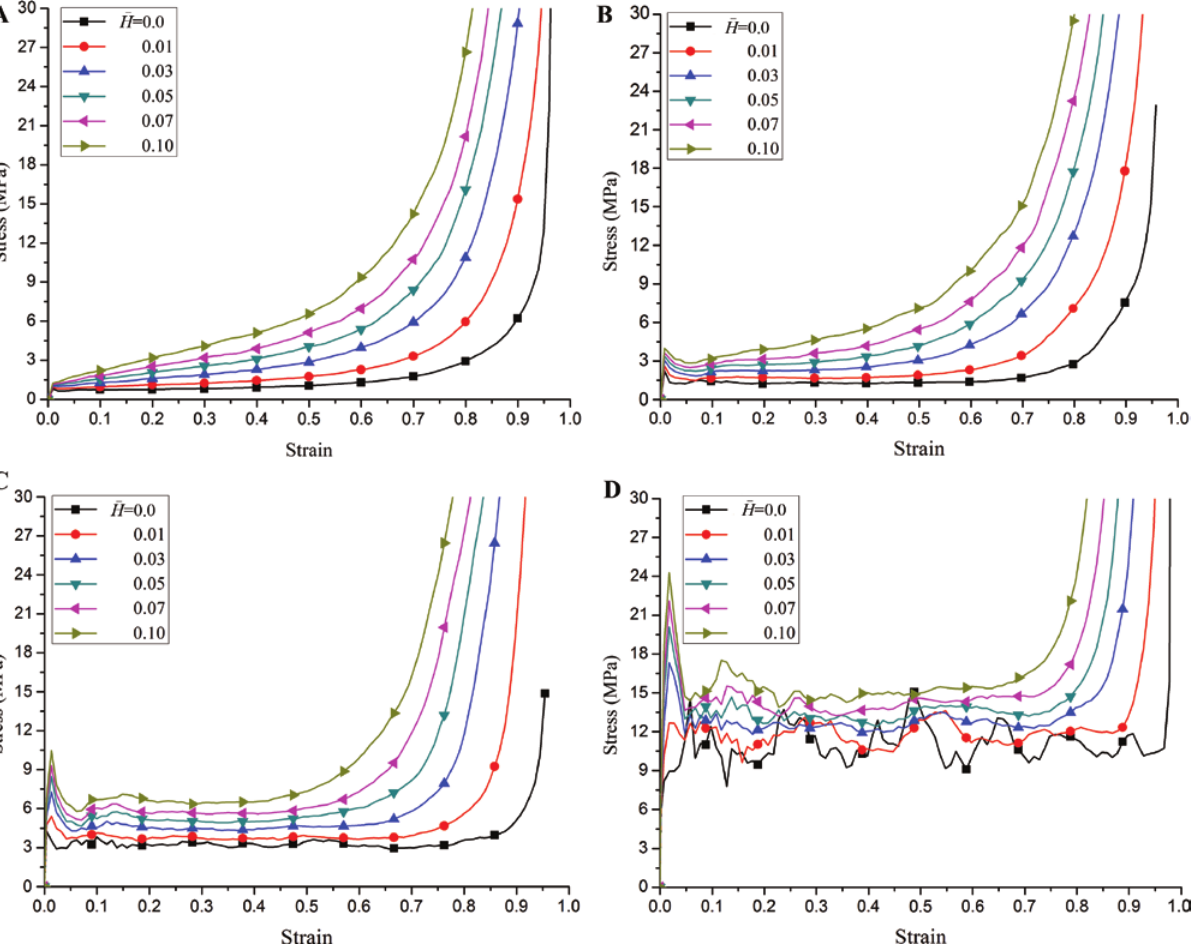
Figure 5: Crushing stress variation at the impact side (A, 10 m/s; B, 50 m/s; C, 120 m/s; D, 250